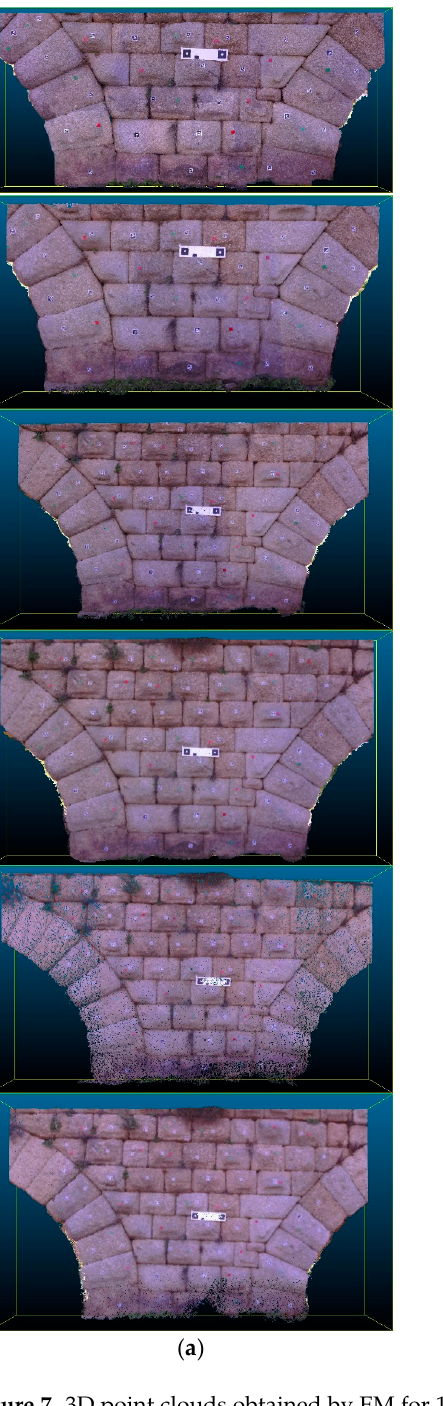
Figure 7. 3D point clouds obtained by EM for 1, 2, 3, 4, 5 and 6 m, from up to down: ( a ) front view; ( b ) middle-side view; and ( c ) right side view.